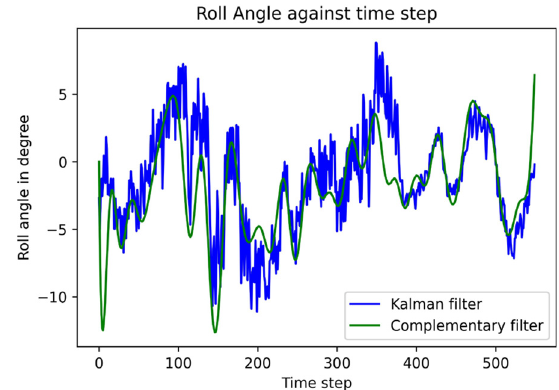
Figure 6 Lean angle using complementary and Kalman fi lter